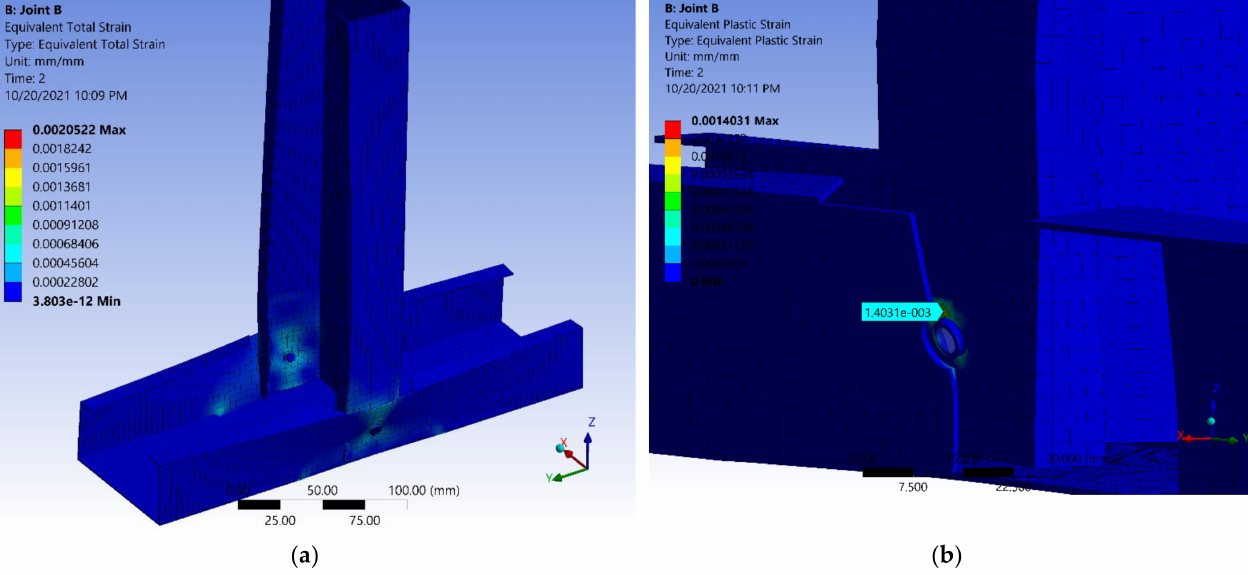
Figure 30. Equivalent strain in joint B at 2 kN—deformed shape: ( a ) overall map total (elastic + plastic) strain; ( b ) detail with plastic